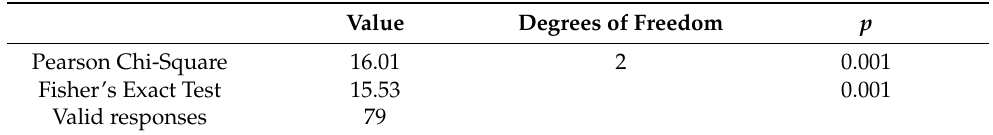
Table 12. Statistical significance of the total amount of time devoted weekly to the physical activity programme based on excess weight category and gender. Value Degrees of Freedom p Pearson Chi-Square